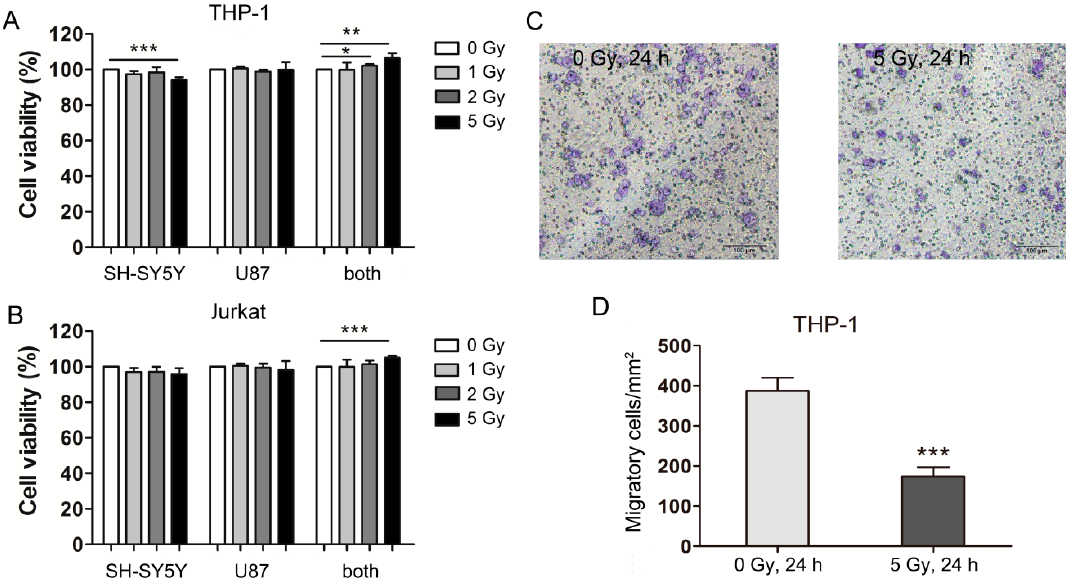
Figure 1. Carbon ion-irradiated neural cells mediate immune effects in vitro . ( A ) THP-1 cells and ( B ) Jurkat cells were cultured in three different types of conditioned medium and cell viability was